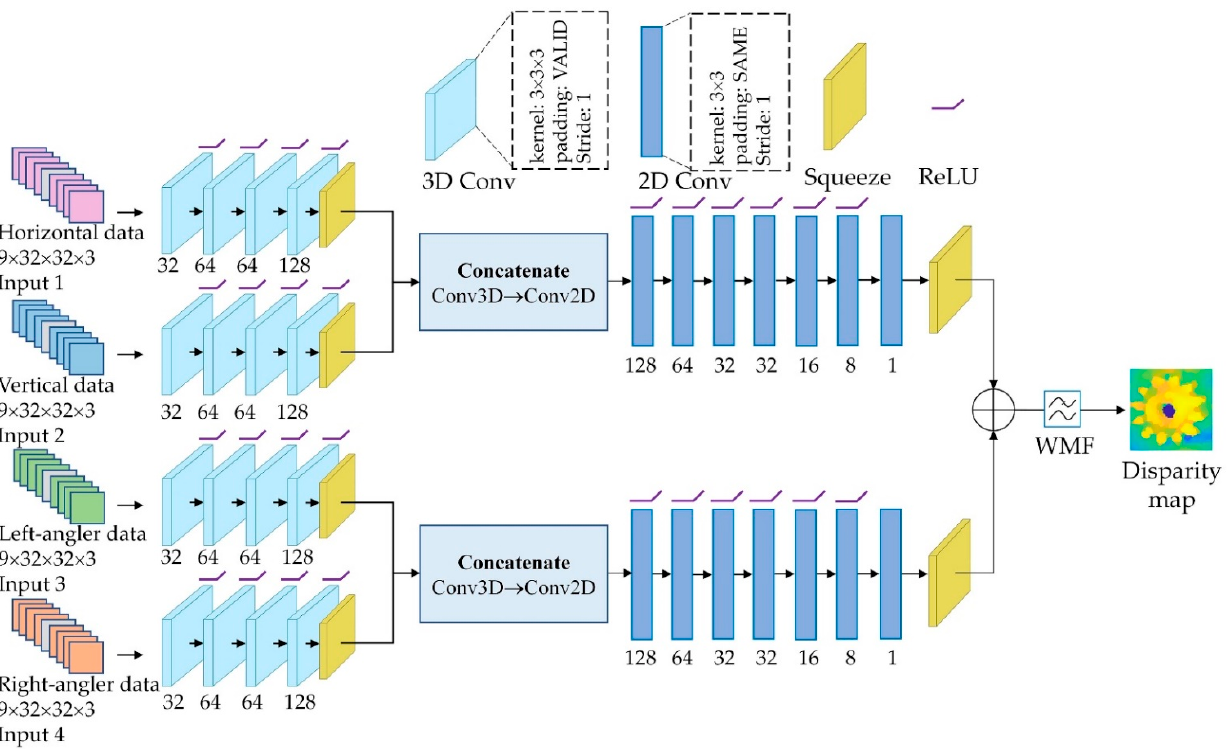
Figure 4. The architecture of the proposed depth estimation network for IIM system. The 2D convolution layer sets acquired from the two streams are combined to create a high-level depiction. The first two and last branches are concatenated and fed into the next 2D convolutional layers to obtain a greater output with minimal loss. The size of the feature maps representing the number of views is decreased to one after the seven convolutions so that a squeezing layer can be applied to remove this dimension and produce 3D data with a size of height × width × 64. As convolutional layers are passed through, the number of feature maps decreases to 128, 64, 32, 32, 16, 8, and 1, respectively, with the kernel size being 3 × 3 and the padding being ‘SAME’. Except for the last convoluted layer, each 2D convoluted layer includes the ‘ReLU’ activation function. A squeezing layer is added at the end of each layer, so the depth map has the dimensions height × width. Finally, two 2D convolution branches are merged into an output layer. A batch size of 32 is used to train the network due to the heavy data and computation involved. For training, set the number of epochs to 2000, the learning rate to 0.0004, and the epochs per decay to 100 with a decay factor of 0.9. After that, the output is passed through the weighted median filtering (WMF) method as shown in Figure 5. The WMF mainly eliminates internal noise while maintaining boundary information, which is essential for depth estimation. A three-channel RGB image should be used as a guidance image for the WMF method for the central directional-view image. A depth estimation image is acquired at the end of this process. A higher-quality image is produced when the WMF method is applied to the initial depth